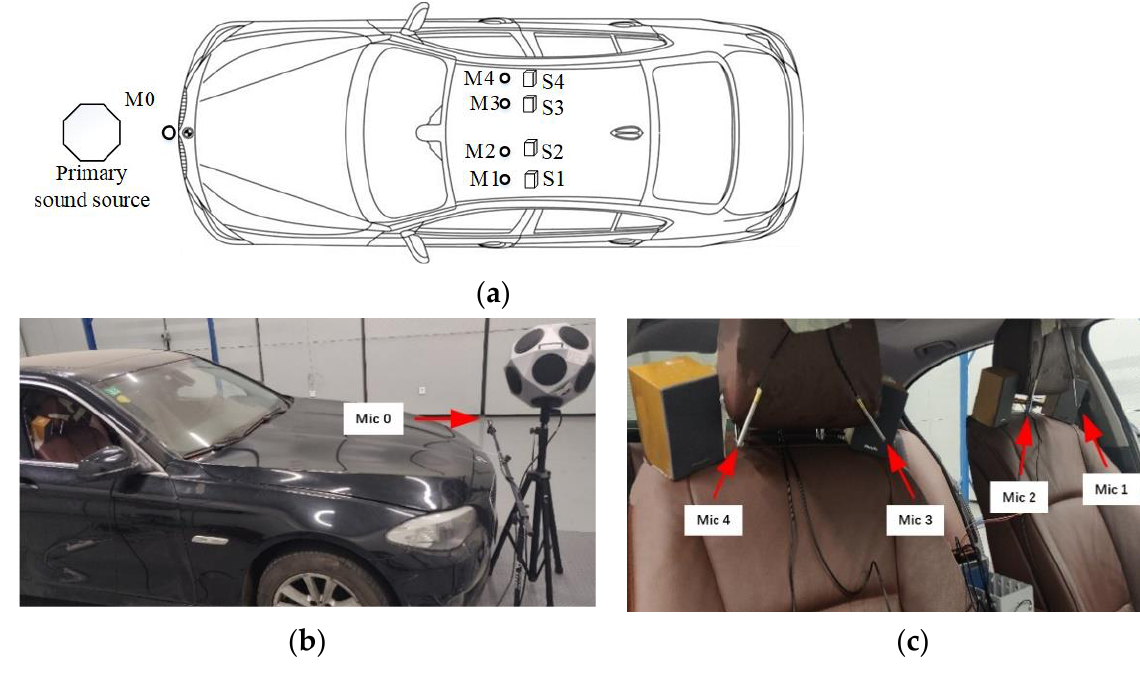
Figure 9. Vehicle multi-channel fractional-order ANC experimental system. ( a ) Laboratory equipment deploymen; ( b ) Arrangement of external sound source of noise in anechoic room; ( c ) Arrangement of internal sensors and speakers in anechoic